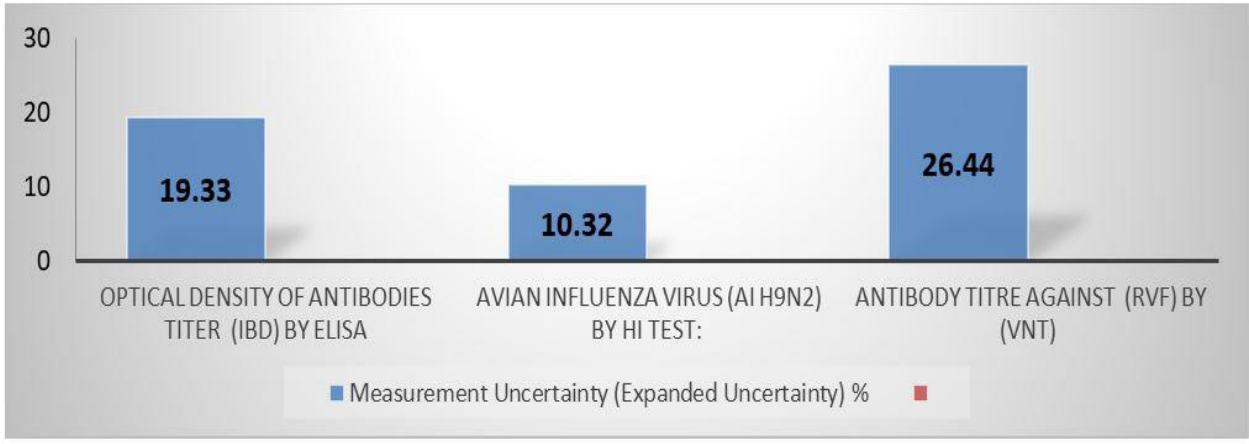
Fig. 8: Comparison of Measurement Uncertainty of Determination of Virus Titer by Different Techniques.